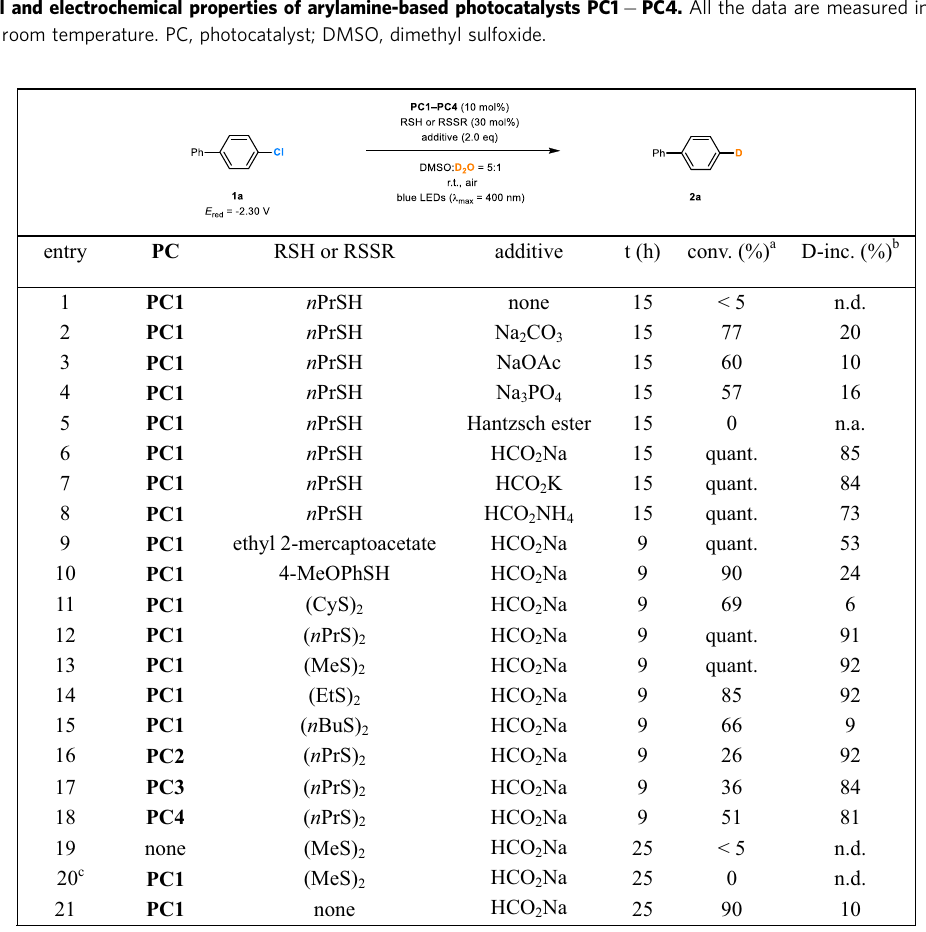
Fig. 3 Initial experiments for photocatalytic deuterodehalogenation of aryl chlorides. Reaction conditions: 1a (0.10 mmol), D 2 O (0.10 mL), PC1 − PC4 (0.0050 mmol), thiol or disul fi de (0.030 mmol), additive (0.20 mmol), DMSO (0.50 mL), a 50 W blue LEDs lamp ( λ max = 400 nm), room temperature (~ 30 °C under irradiation), in air. a Degree of conversion determined by 1 H-NMR. b D-inc. determined by 1 H-NMR. c In the dark. PC, photocatalyst; eq, equivalent; r.t., room temperature; conv., conversion; D-inc., deuterium incorporation; t, reaction time; quant., quantitative conversion; n.d., not determined; n.a., not applicable; DMSO, dimethyl